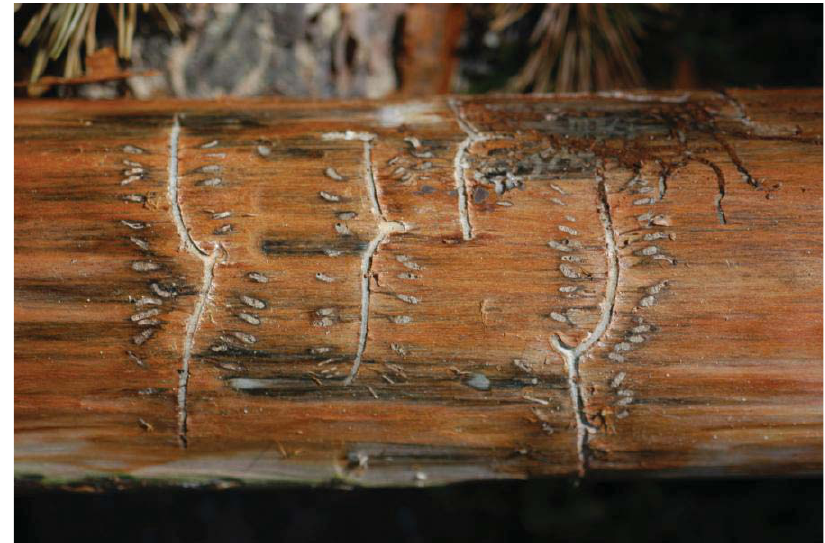
Figure 2. Blue stain caused by ophiostomatoid fungi in the galleries of Tomicus minor on Pinus sylvestris